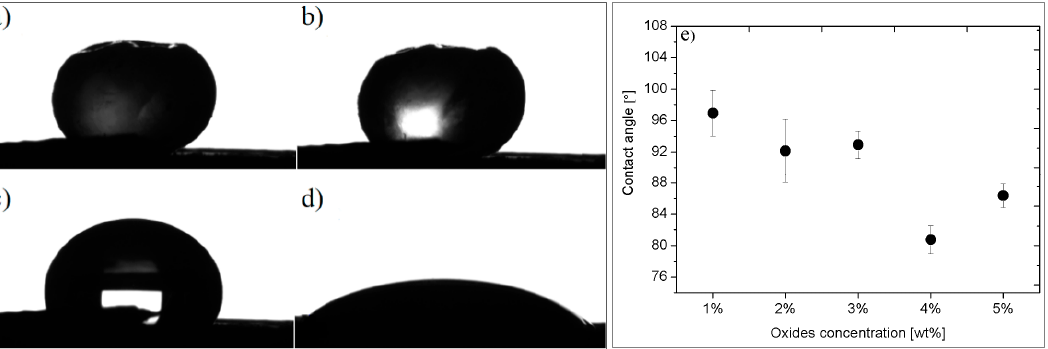
Figure 2. Images of the PA12 pellet melted at the filler surface: ( a ) original PA12 pellet; ( b ) first softening of the pellet at 150 ◦ C; ( c ) completely melted PA12 at 180 ◦ C; ( d ) wetting of the filler tablet by fully spread PA12 polymer at 224 ◦ C; ( e ) dependence between contact angle of in PA12 composites and metal oxides